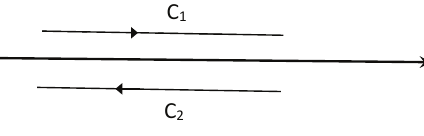
Figure 2. Sketch of the Keldysh contour C K